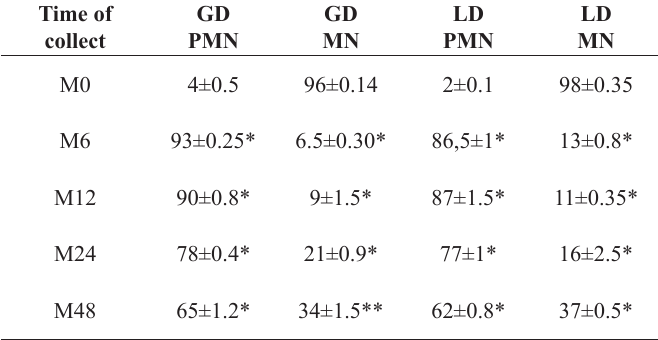
TABLE 1 - Percentage of differential count of synovial fluid cells from horses collected before and after liquid or gas capsular distension during experimental arthroscopy (means ± SEMs). M0, M6, M12, M24 and M48= before and at 6, 12, 24 and 48 hours after arthroscopy, respectively. GD= Gas distension; LD= liquid distension.